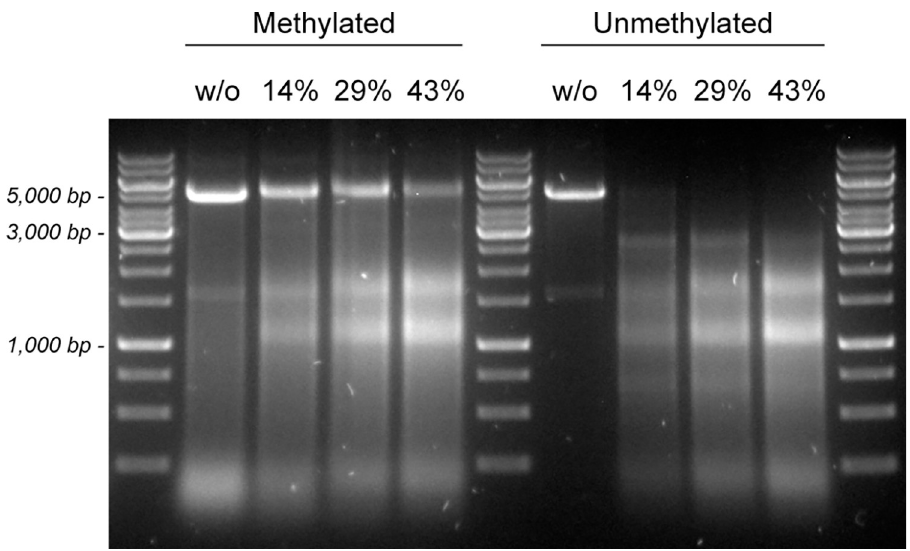
Fig 4. Degradation of a methylated and unmethylated DNA fragment by endogenous nucleases present in a BluCon085 cell lysate. The methylated and unmethylated DNA fragments were incubated in the absence of cell lysate (w/o), and in the presence of 14%, 29% and 43% of cell lysate. The incubation was performed at 70˚C for 30